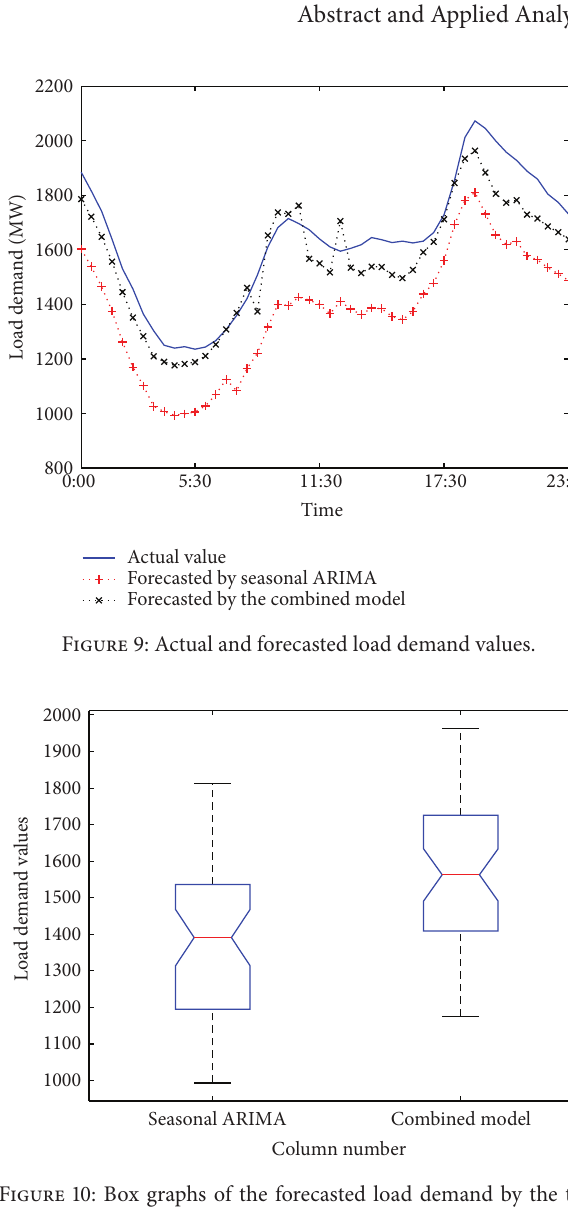
Figure 10: Box graphs of the forecasted load demand by the two